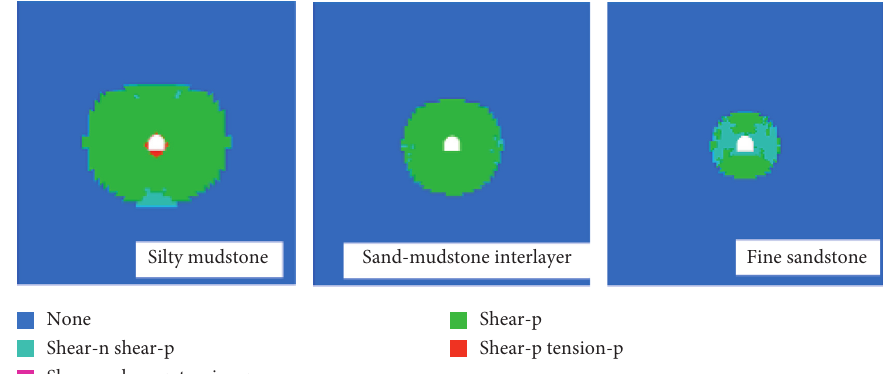
Figure 10: Distribution laws of the plastic zone of the surrounding rock under different lithology